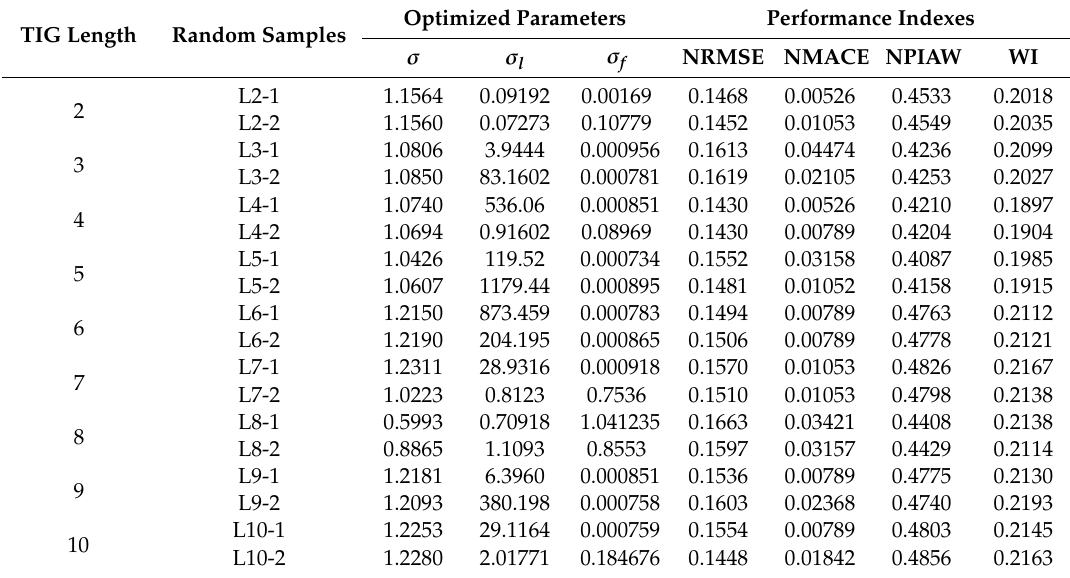
Table 1. Testing of TIG